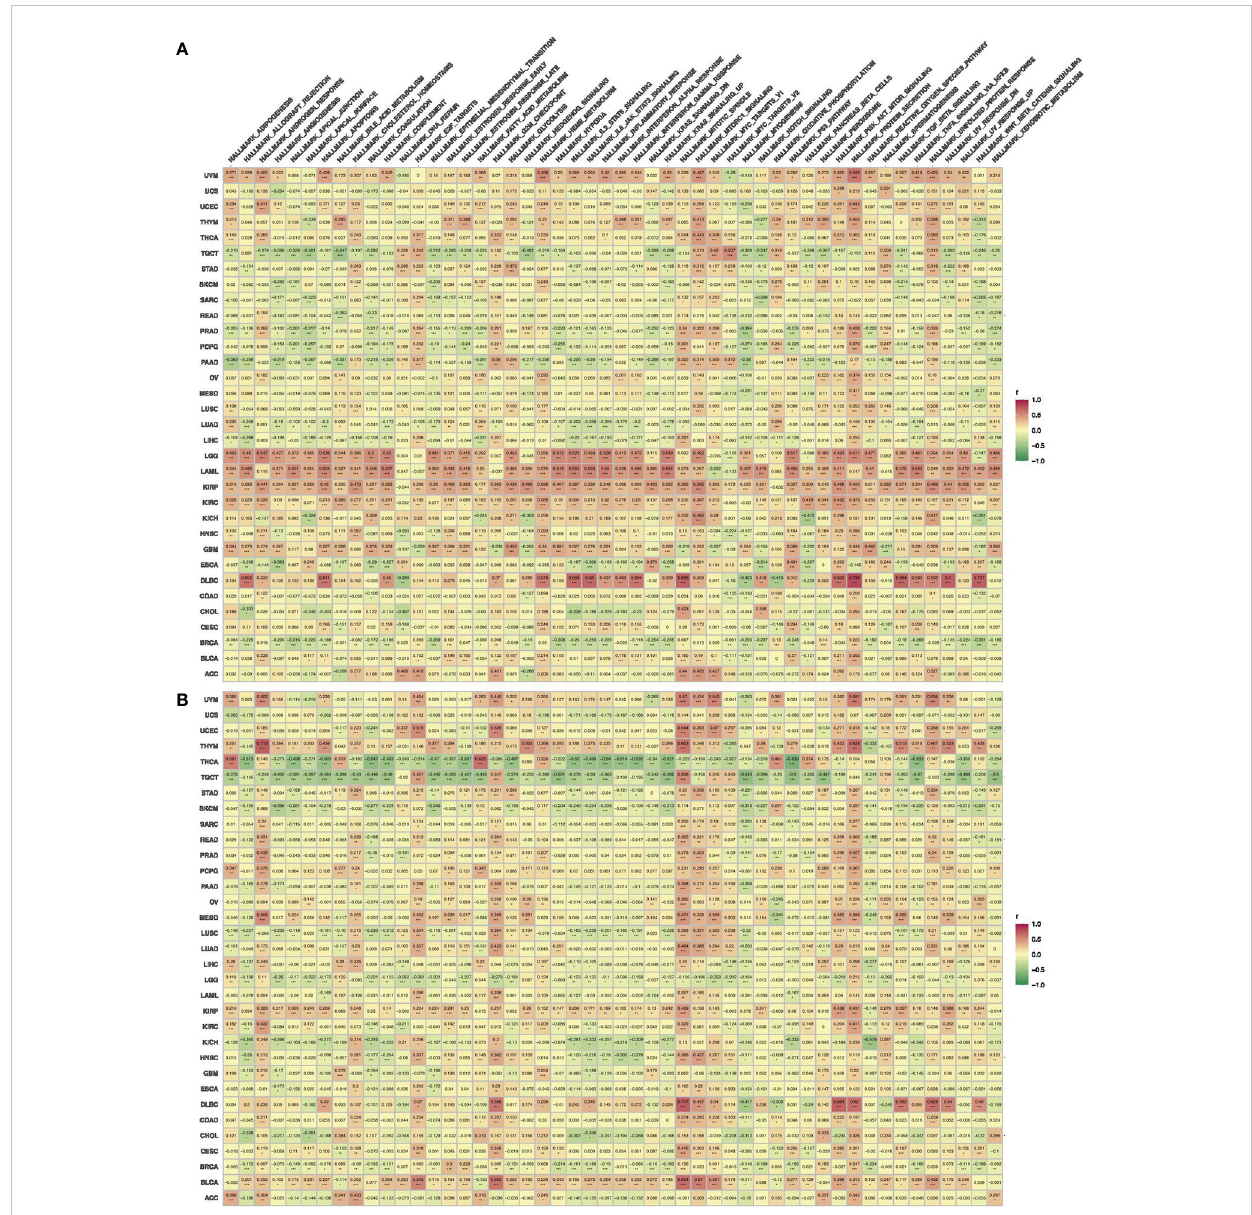
FIGURE 9 The correlations of HallMark pathways with ADIPOR1 (A) and ADIPOR2 (B) . *P < 0.05, **P < 0.01, ***P <